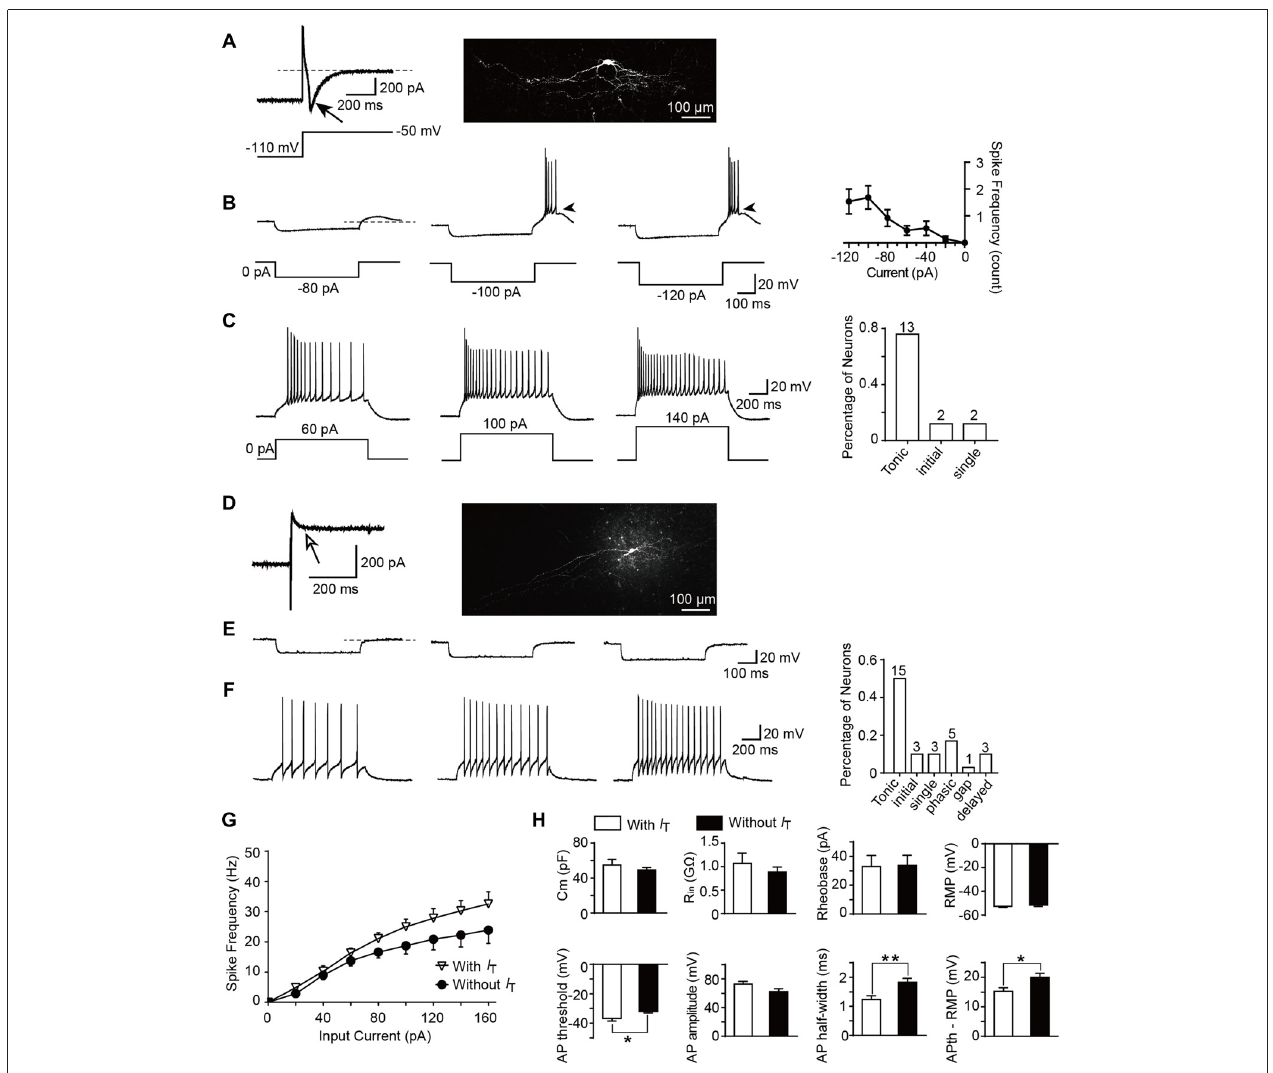
FIGURE 5 | Active and passive membrane properties of T-type current-expressing and -lacking SG neurons. (A) Left: a representative T-type current trace evoked by 1 s hyperpolarizing potential ( − 110 mV) to test potential ( − 50 mV). Right: morphology of the neurobiotin 488-filled neuron that shown on the left. Black arrow indicates T-type current. (B) Representative current-clamp traces from the same SG neuron in (A) at the indicated hyperpolarizing currents of − 80 pA, − 100 pA and − 120 pA. Right panel: plot of rebound depolarization-evoked spike frequency as a function of test potentials. Arrowheads indicate low threshold spikes. (C) Representative current-clamp traces from the same SG neuron in (A) depicting active membrane responses to increasing depolarizing current injection of 60 pA, 100 pA and 140 pA. Right panel: the fraction of various firing pattern in T-type calcium channel-expressing neurons (the numbers indicate the neurons examined). (D) Left: a representative response to the same protocol in (A) in a neuron lacking T-type calcium channel. Right: morphology of the neurobiotin-filled neuron that shown on the left. White arrow indicates no detection of T-type current. (E) Representative current-clamp responses to the same protocol in (B) from the same SG neuron in (D) . (F) Representative current-clamp traces from the same SG neuron in (D) depicting active membrane responses to the same protocol in (C) . Right panel: The fraction of various firing pattern in T-type current-lacking neurons (the numbers indicate the neurons examined). (G) Corresponding average active spikes for tonic firing neurons in T-type current-expressing and -lacking neurons. (H) Bar plots showing the various intrinsic membrane properties of SG neurons expressing or lacking T-type current. Cm: membrane capacitance. R in : input resistance. Rheobase: rheobase current. RMP: resting membrane potential. AP: action potential. APth: action potential threshold. ∗ P < 0.05, ∗∗ P <